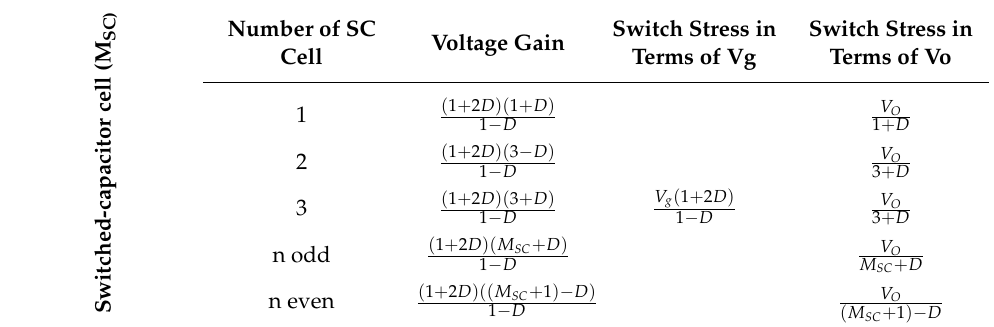
Table 3. Correlations for 1, 2…M SCn Switched-capacitor cell (M SC ) with single Switched-inductor cell.